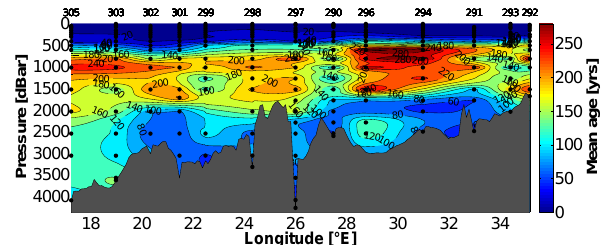
Figure 20. Best estimate of the mean age of the EMed based on the Fig. 20: Best estimate of the mean age of the EMed based on the combination of an IG-TTD and a predefined 2IG-TTD combination of an IG-TTD and a predefined 2IG-TTD constrained constrained by the transient tracer couple CFC-12 and SF 6 . by the transient tracer couple CFC-12 and SF 6